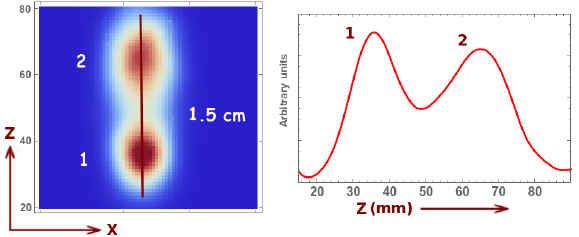
Figure 9. Image reconstruction (five iterations and three sub-iterations) and profile for a two-sphere phantom with 1.5 cm diameter and 3.0 cm distance in between their centers, 1 min acquisition time and 0.1 Mbq activity (of each sphere). The distance in z stands for the distance from the collimator.